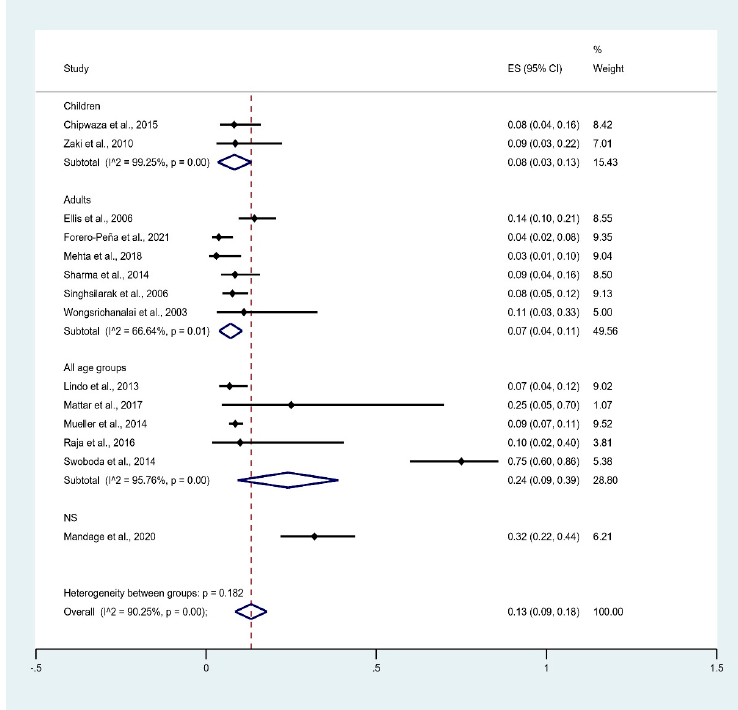
Figure 6. Prevalence of leptospirosis infection among malaria patients by age group. % Weighted: the impact proportion of each study to the pooled effect; black dot symbol on black horizontal line: point estimate for each study; black horizontal line: CI, white diamond symbol: pooled prevalence; CI: confidence interval; ES: effect size (prevalence).